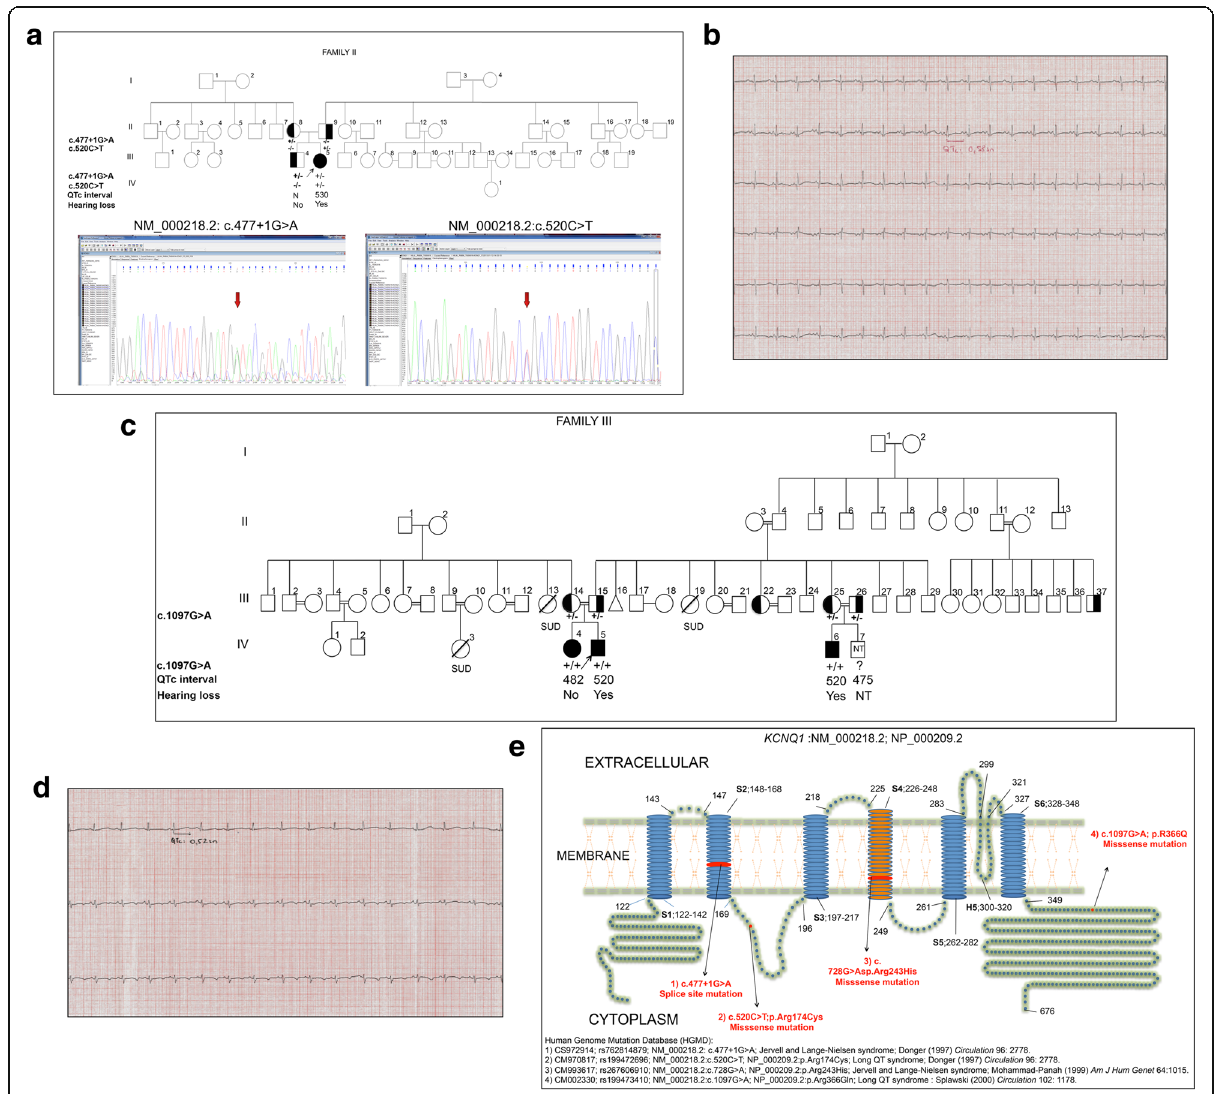
Fig. 2 The molecular and clinical findings for family II and family III, and KCNQ1 mutations illustrated on KCNQ1 protein ( a ) Pedigree of the family II; Case 2 (III-5) who is carrying compound heterozygous mutations of c.477 + 1G > A and c.520C > T (p.Arg174Cys) in KCNQ1 gene and the carrier status of the other family members were shown above, (N = Normal, +: Mutant allele, − : Normal allele), DNA sequencing images of the mutations in the proband were presented below ( b ) The ECG of the proband (III-5) in family II showing the prolongation of QTc (530 ms) interval ( c ) Pedigree of the family III; Case 3 (IV-5) who is carrying the c.1097G > A (p.R366Q) mutation in KCNQ1 gene and the carrier status of the other family members were presented (N = Normal, SUD = Sudden unidentified death, NT = Not tested, +:Mutant allele, − :Normal allele) ( d ) The ECG of the proband (IV-5) in family III showing the prolongation of QTc (520 ms) ( e ) The illustration showing all of the KCNQ1 mutations seen in our three cases (S1, S2, S3, S5,S6: Helical, transmembranic domains; S4:Helical, Voltage-sensor, transmembranic domain; H5: Pore-forming, intramembranic